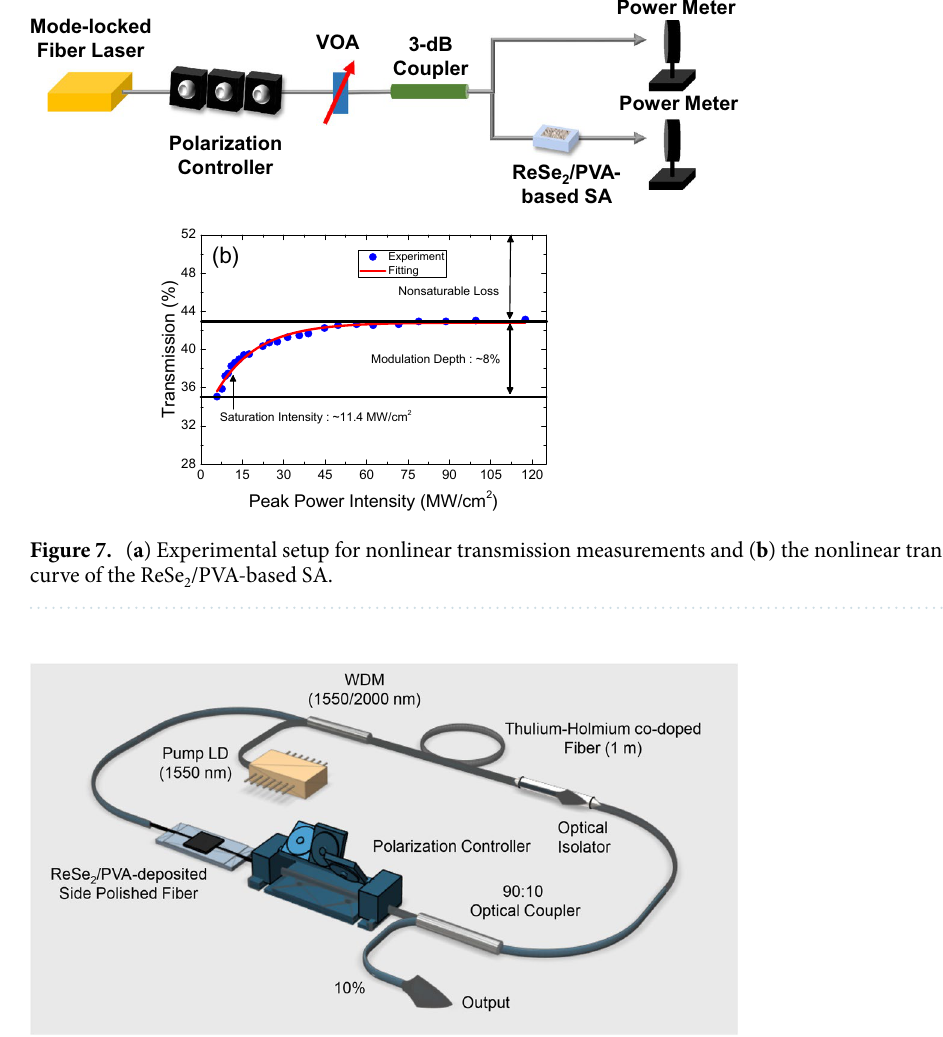
Figure 8. The fiber laser configuration and